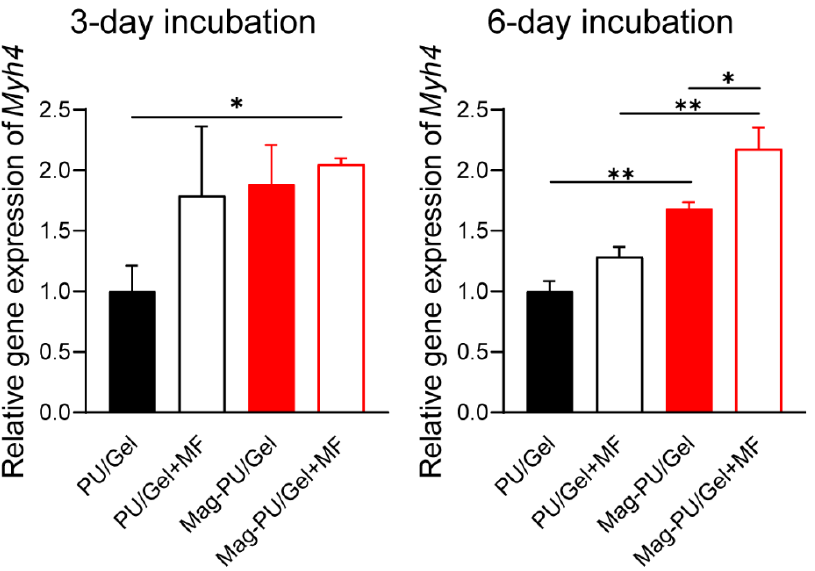
Figure 4. Gene expression of Myh4 in C2C12 cells grown on different scaffolds for 3 days and 6 days with and without the applied magnetic fields. These data were analyzed by one-way analysis of variance with Tukey’s post hoc test : * p < 0.05, ** p < 0.01. * indicated significant difference.